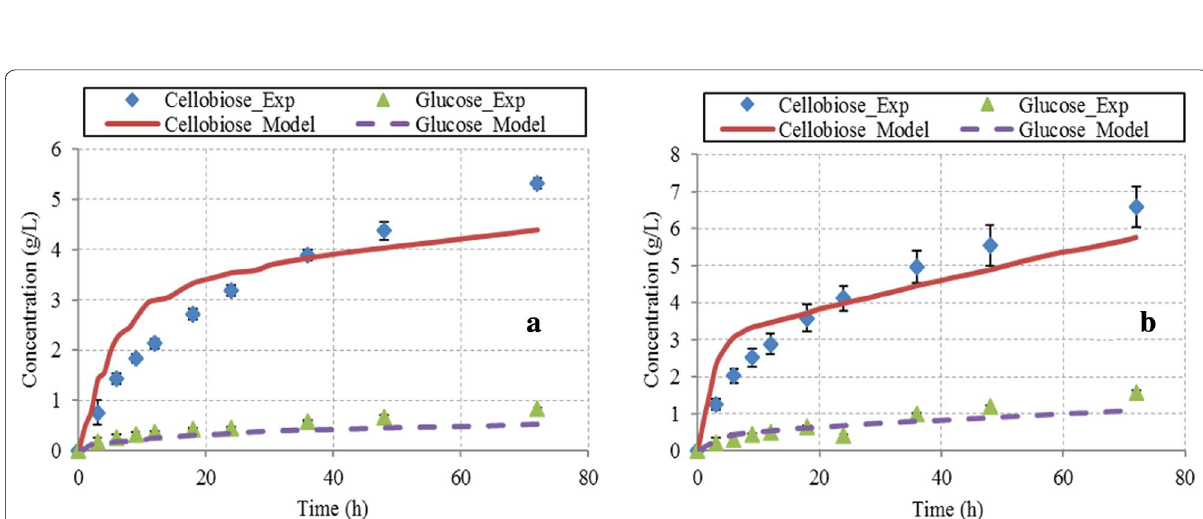
Fig. 11 Comparison of model simulations and experimental observations of sugar production during hydrolysis of filter paper (25 g/L) at a CBH II loading of 5 mg/g cellulose, b CBH II loading of 15 mg/g